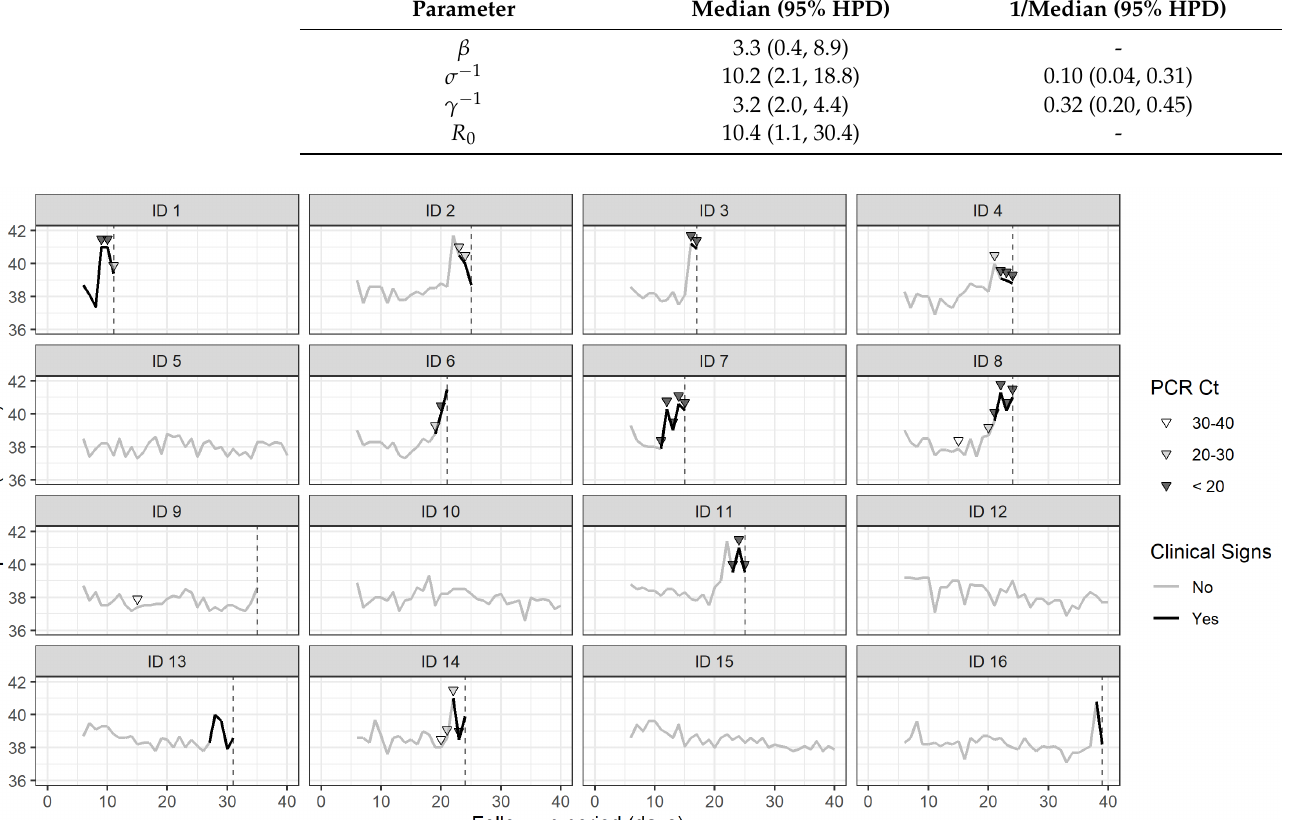
, the and the basic 𝛽𝛽 −1 𝛾𝛾